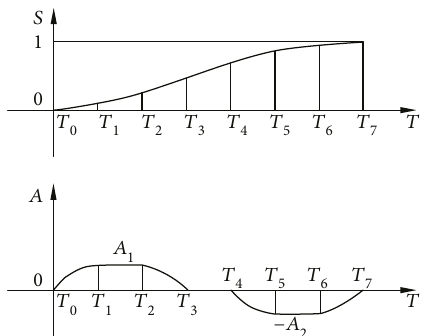
Figure 13: A general harmonic trapezoidal